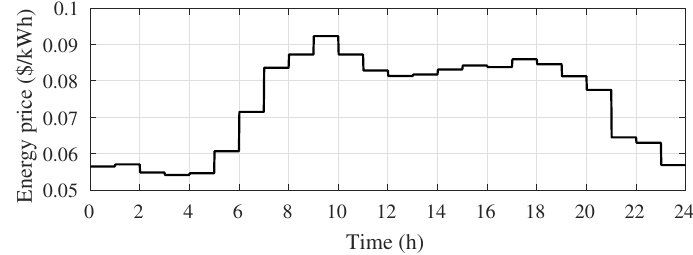
Figure 11. Dynamic energy price profile for the entire day. By analyzing the price curve, the sweet spot for EV charging is during the night and early morning period, specifically between 9 p.m. and 6 a.m. However, throughout the day the price level does not present drastic variations, remaining between 0.08 and 0.09 $/kWh. The relation of EV with the power factor can be examined in Figure 12, and it is observed the same aspect of the previous scenario, the power factor keeps above the 0.95 sets as reference.